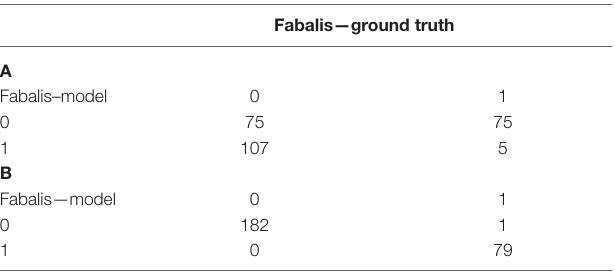
TABLE 5 | Assignment of individuals to subspecies class by the kmeans models against the ground truth classification.